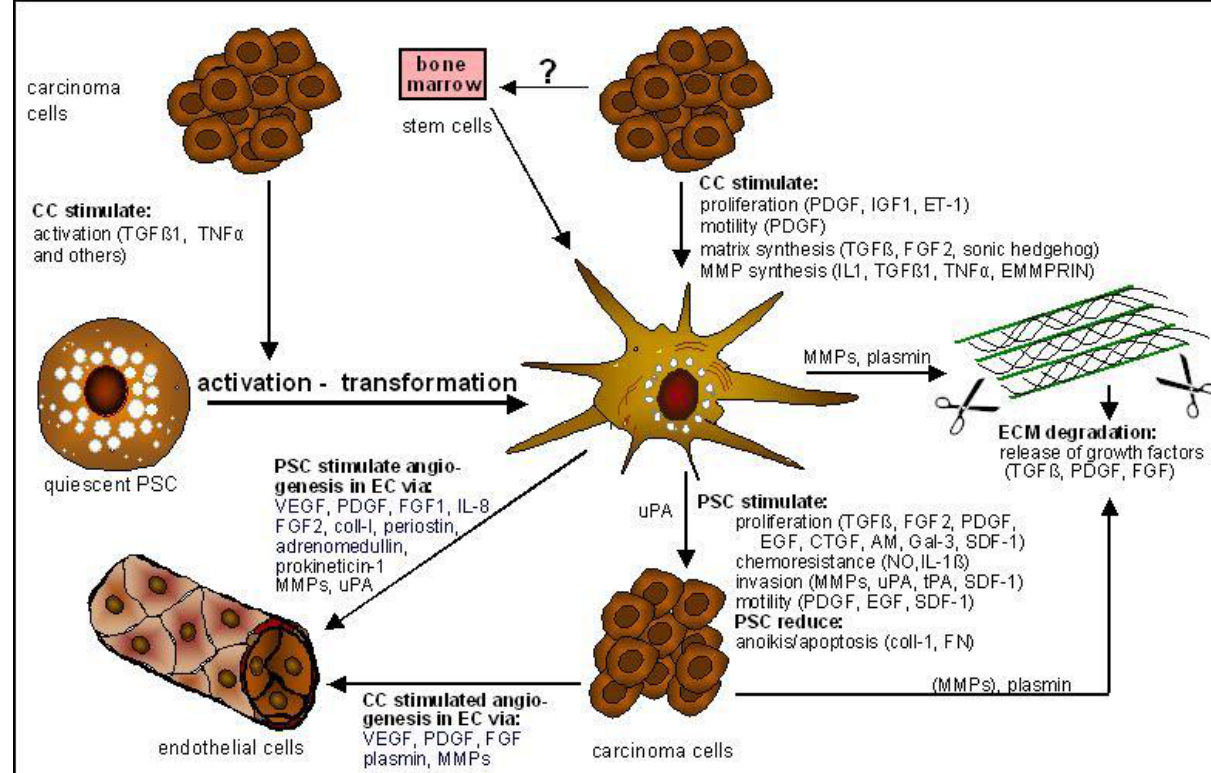
Figure 4. Interaction of PSC with pancreas carcinoma cells. Pancreas carcinoma cells (CC) accelerate transformation of quiescent PSC to the myofibroblast-like phenotype. This cell type is attracted by CC and stimulated to proliferate, produce ECM and growth factors. PSC stimulate angiogenesis, CC proliferation, chemoresistance, invasion, and motility. In addition, PSC reduce anoikis/apoptosis of CC. AM, adrenomedullin; SDF-1, stromal cell-derived